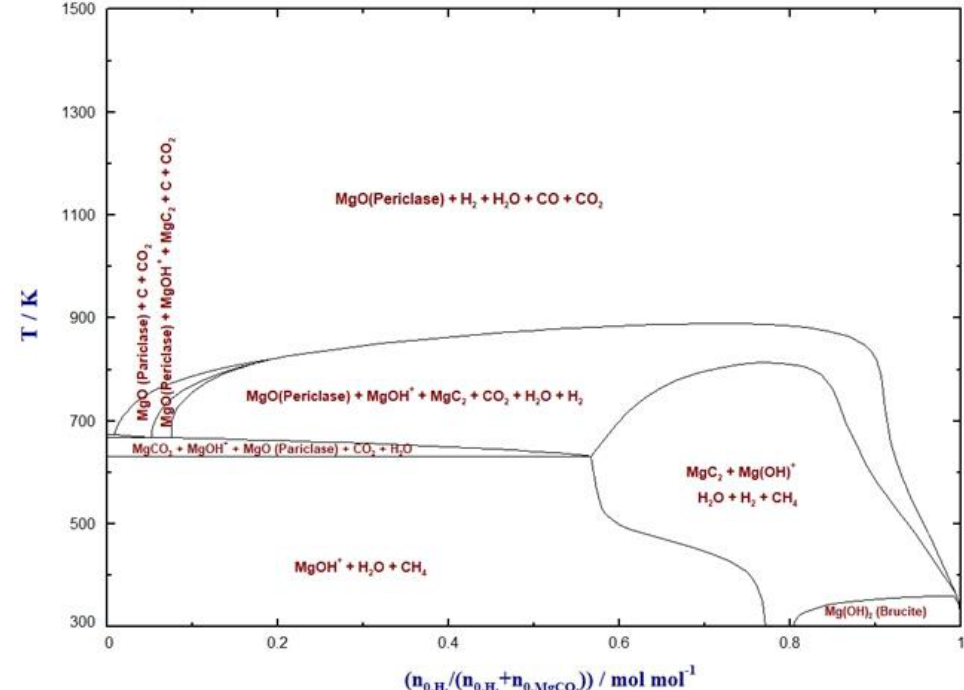
Figure 7. Equilibrium solid phase diagram of the system MgCO 3 –H 2 : solid phase fields were predicted as a function of the temperature and the feed hydrogen mole fraction; gaseous products are not shown; data calculated with FactSage 8.0™ (Thermfact and GTT-Technologies). The solid phases at equilibrium were predicted as a function of the temperature and the feed H 2 ( 𝑛 0 + n 0,MgCO 3 )), where n 0 denotes the number of moles of the feed component.